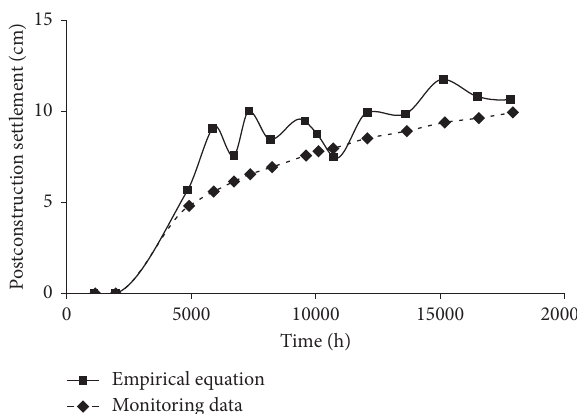
Figure 9: Postconstruction settlement contrast curves between the empirical equation and monitoring point